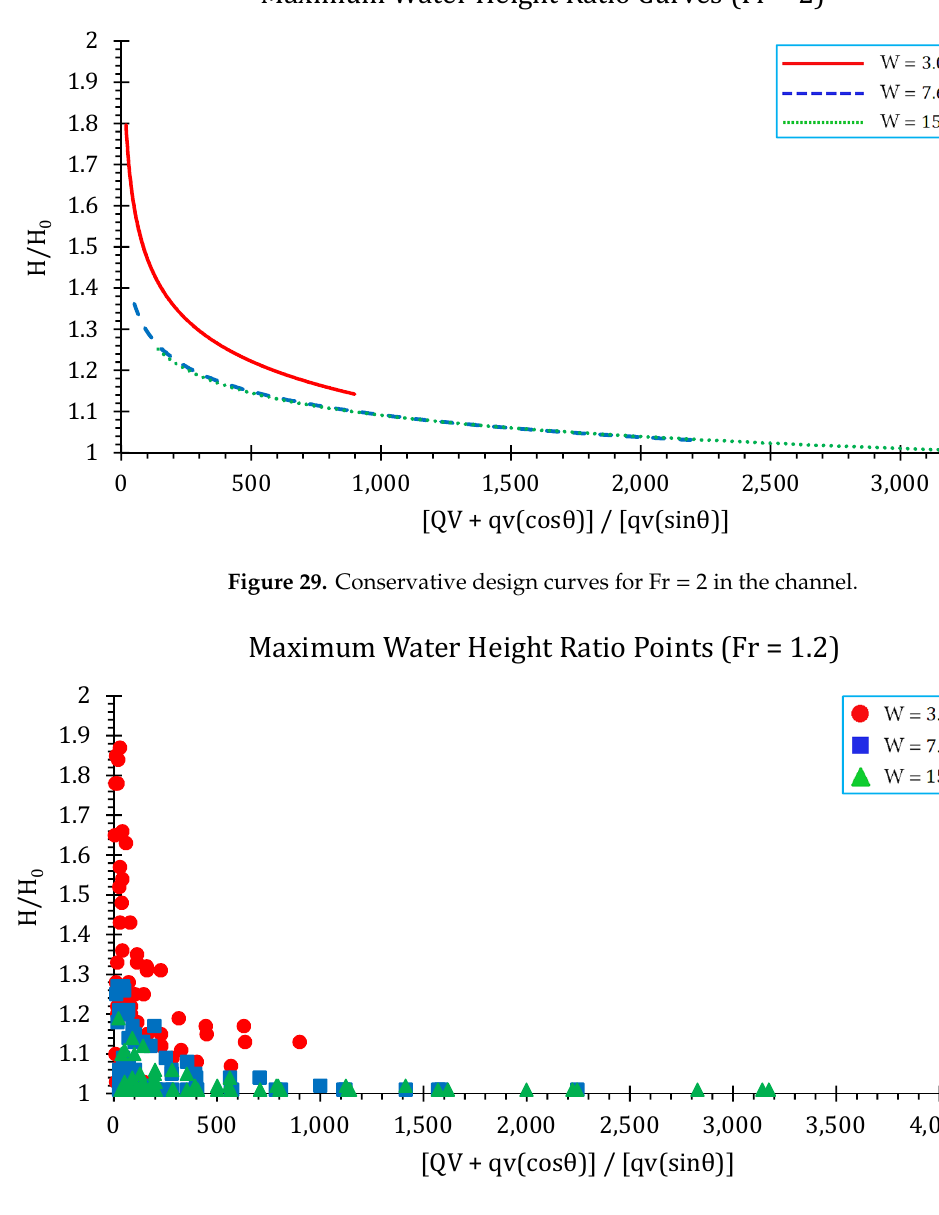
Figure 30. Simulation results for Fr = 1.2 in the channel.